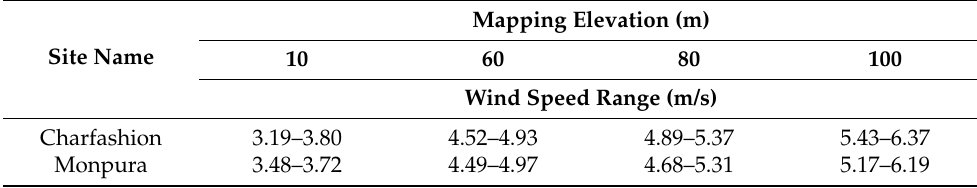
Table 9. Wind speed ranges from the microscale maps of the Charfashion and Monpura micro- sites.